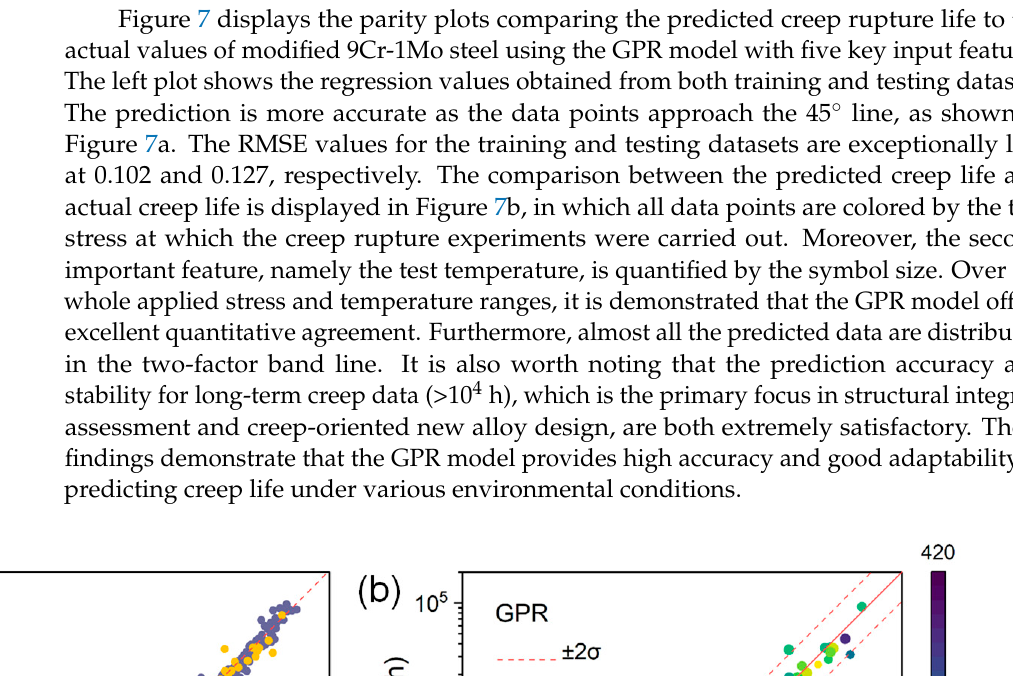
Figure 6. Comparison of accuracy for di ff erent machine learning models: ( a ) RMSE and ( b ) R 2 .